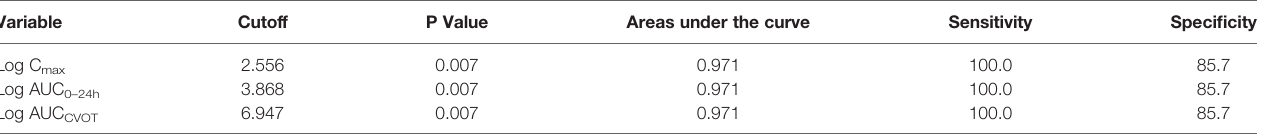
TABLE 3 | ROC Curves of all continuous variables. Variable Cutoff P Value Areas under the